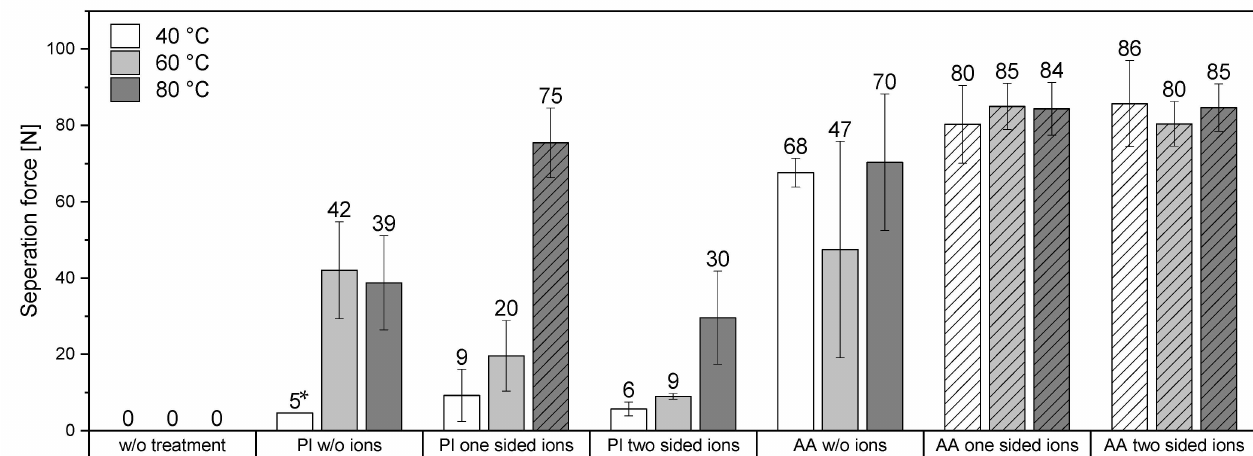
Figure 6. Separation force of bonded substrates, measured by a LUMifrac device, at different temperatures (40 ◦ C, 60 ◦ C, and 80 ◦ C) and with various surface treatments. Pl = plasma-treated, AA = acrylic-acid-grafted surface, w / o ions = without ions, one sided ions = only one of the two bonded substrates had been loaded with Cu ions, two sided ions = both sides of the bonded substrates had been loaded with Cu ions. Hatched boxes = cohesive failure, i.e., the real separation force is higher but not measurable. Unless otherwise indicated, five samples per experiment were tested. * = only one out of seven samples bonded